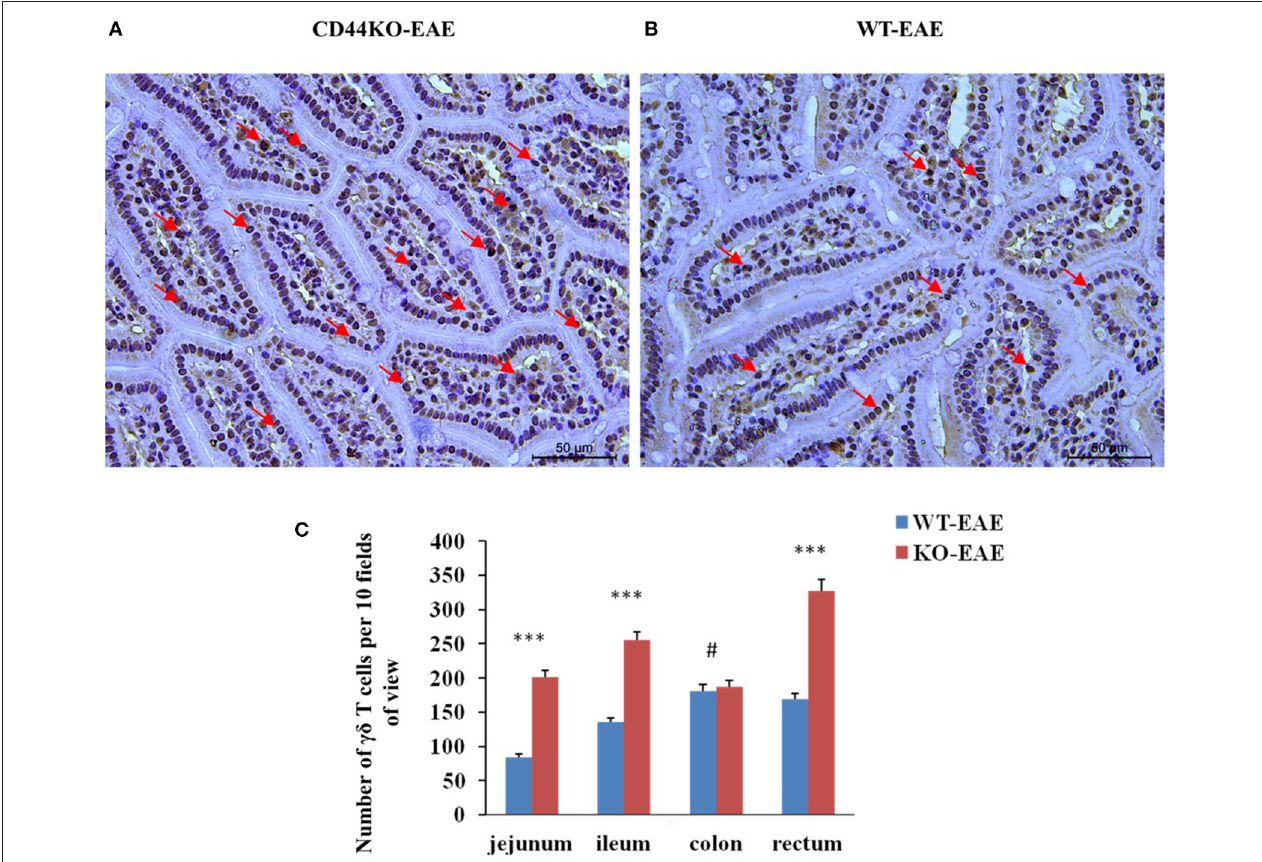
FIGURE 5 | Significantly more γδ T cells were observed in the intestines of EAE-resistant mice. Representative histological appearances of jejunal tissues of CD44-EAE and WT-EAE mice on day 15 post-immunization, parts of γδ T cells with GL3 positive staining were pointed with red arrows. (A) Jejunum of a CD44KO-EAE mice. (B) Jejunum of a WT-EAE mice. (C) Mean numbers of γδ T cells in the jejunum, ileum, colon and rectum of 10 high-power field. Data from three separate experiments with five mice/group are presented as mean ± SEM. Data were analyzed with Student’s t -test: *** P < 0.001, # P >